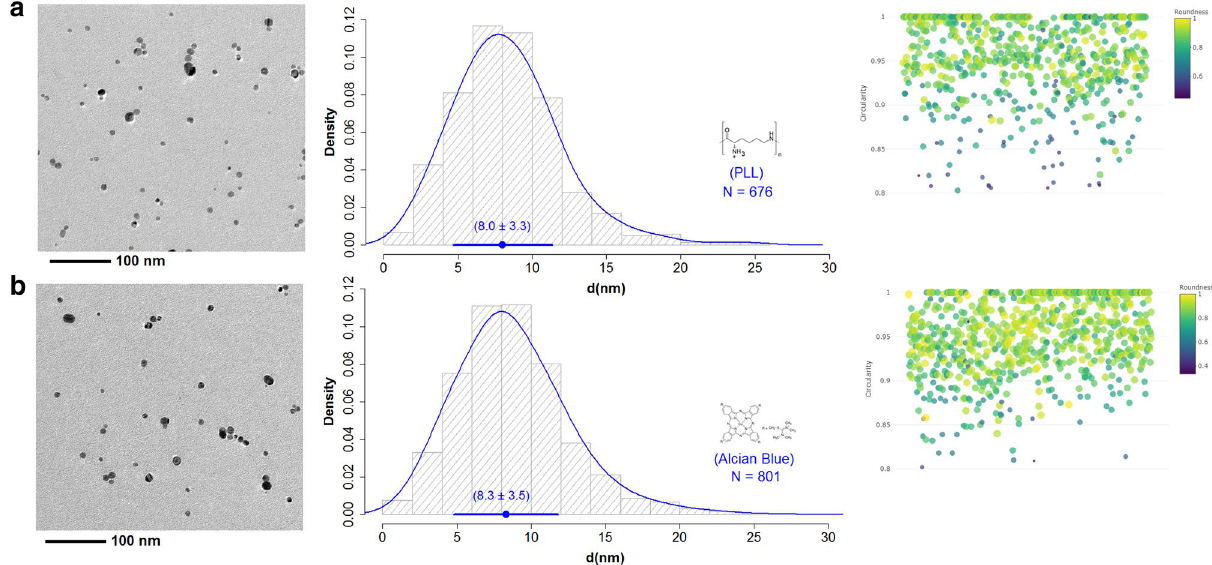
Figure 4. Characterization of the particle size, size distribution, and shape descriptors of the purified AgNPs by TEM. ( a ) AgNPs deposited using PLL, ( b ) AgNPs deposited using Alcian